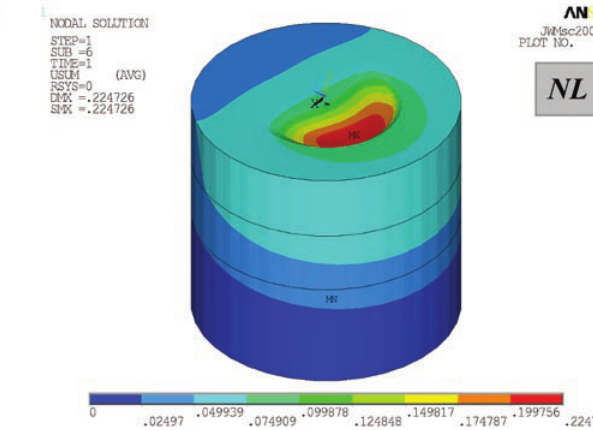
Fig. 9a. Foundation settlements in the section per node of the max settlement s max , NL = 0.225